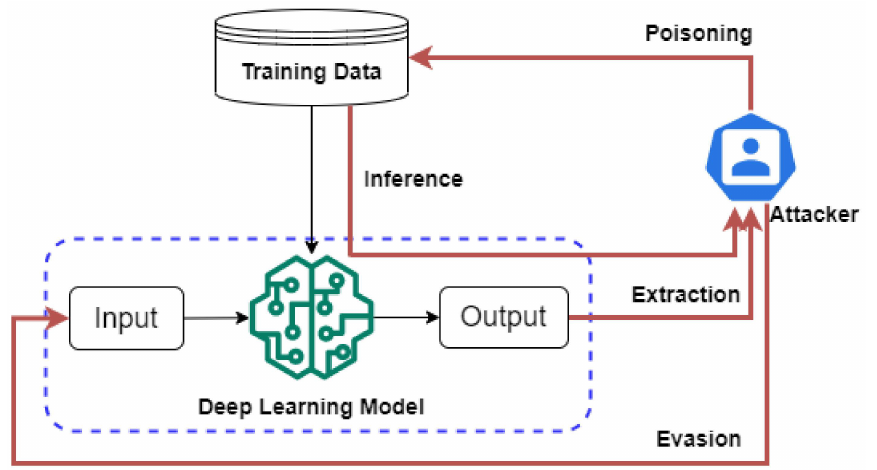
Figure 14. Four categories of attack in deep learning